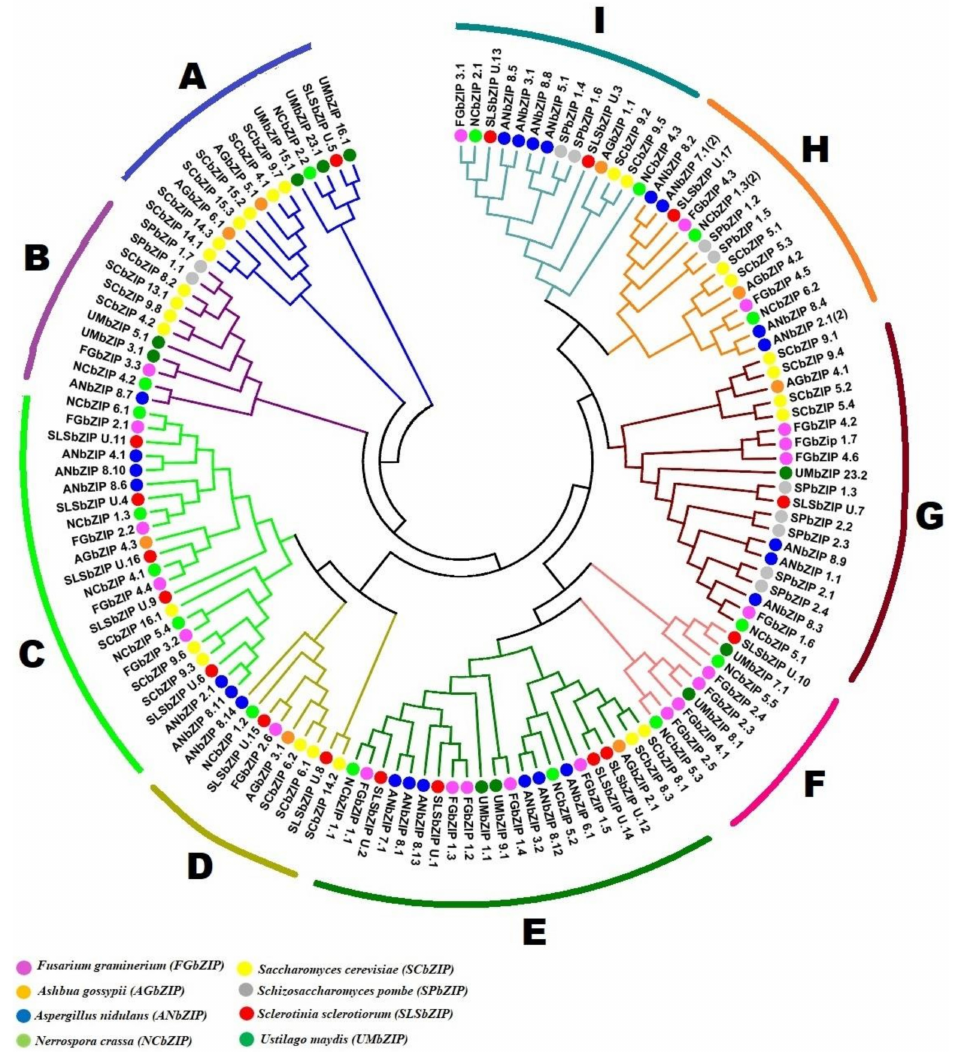
Figure 2. Phylogenetic tree constructed using 135 full-length bZIP protein sequences. The phyloge- netic tree was constructed in MEGAX using maximum likelihood method after aligning with the ClustalW program and the bootstrap iterations value was 1000 to generate tree. The proteins are clus- tered into nine clades ( A – I ) indicated by colored branches. The FgbZIPs are denoted by pink circles while. Ashbya gossypii, Aspergillus nidulans, Neurospora crassa, S. cerevisiae, Schizosaccharomyces pombe, S. sclerotiorum and Ustilago maydis are indicated with orange, blue, green, yellow, silver, red and dark green colored circles